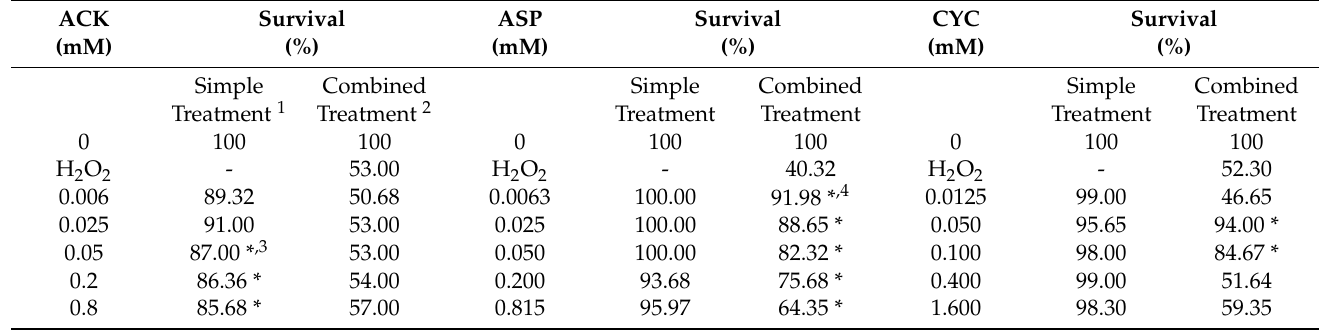
Table 2. Toxicity and antitoxicity levels of ASP, ACK and CYC in D. melanogaster